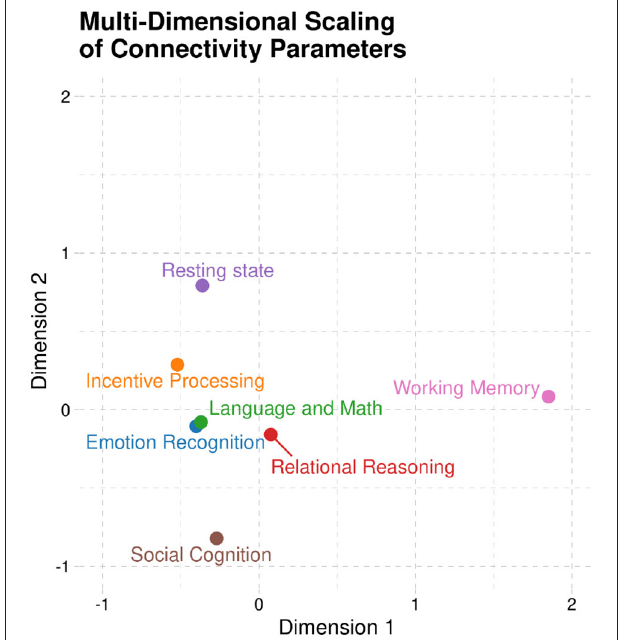
FIGURE 11 | A comparison of the group-averaged intrinsic connectivity parameters derived from task-based recordings (blue) and resting-state sessions (red). The blue error bars represent the standard deviation of the task-based parameters.